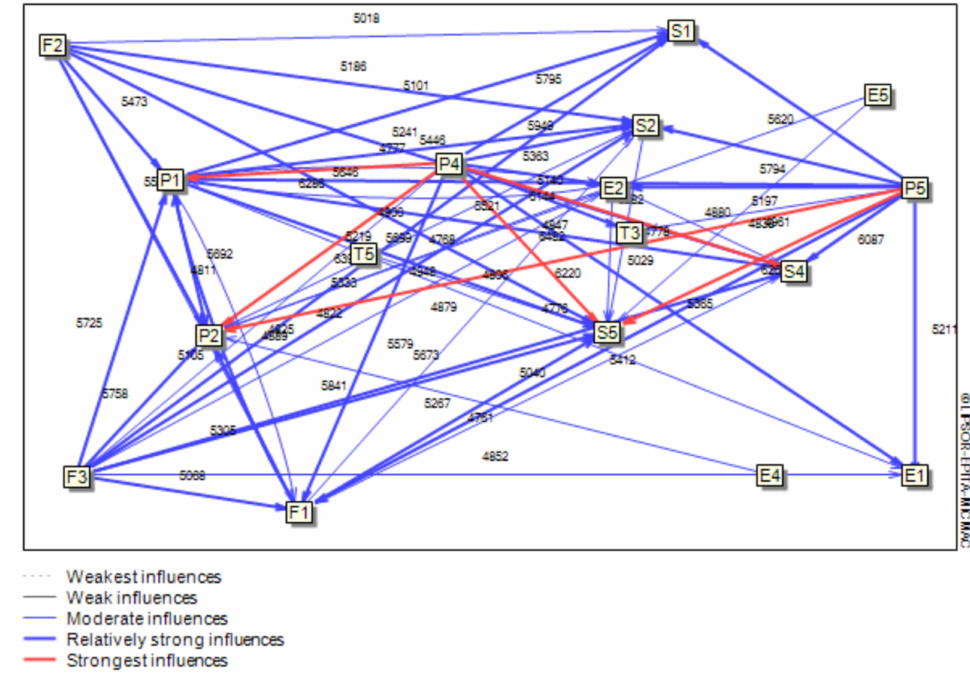
Figure 7. Indirect influence graph of BSSs’